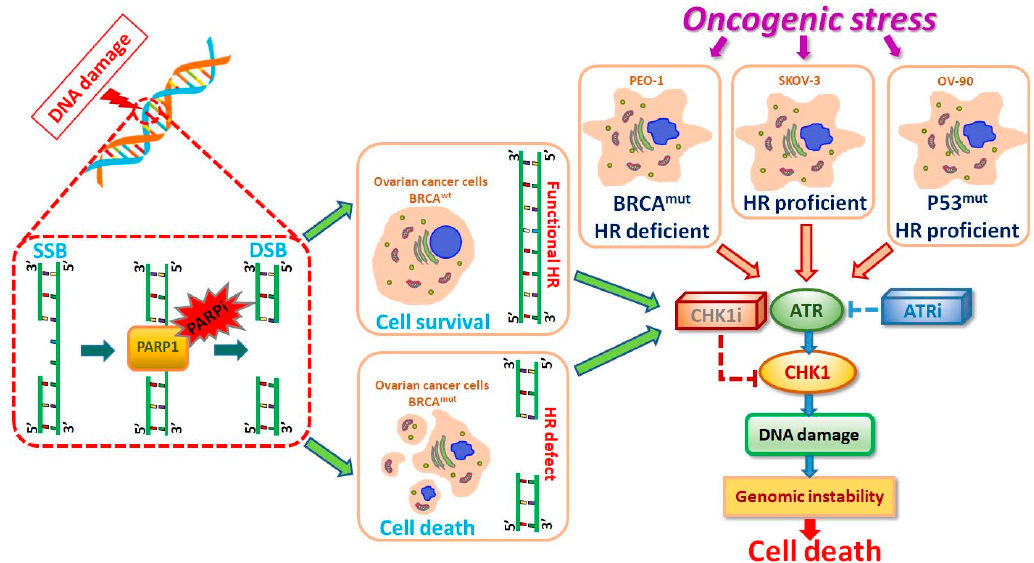
Figure 5. Proposed model of the molecular and cellular responses to new replication stress inhibitors. ATR / CHK1 stabilizes replication forks and prevents their collapse into DSBs. SSBs can be accurately repaired using the undamaged strand as a template, a process involving the PARP enzyme. SSBs are mainly repaired through the homologous recombination (HR) pathway. BRCA is related to the error-free repair of DSBs by HR. ATRi or CHK1i in monotherapy and in combined treatment with PARPi cause genome instability and leads to the synthetic lethality of ovarian cancer cells.